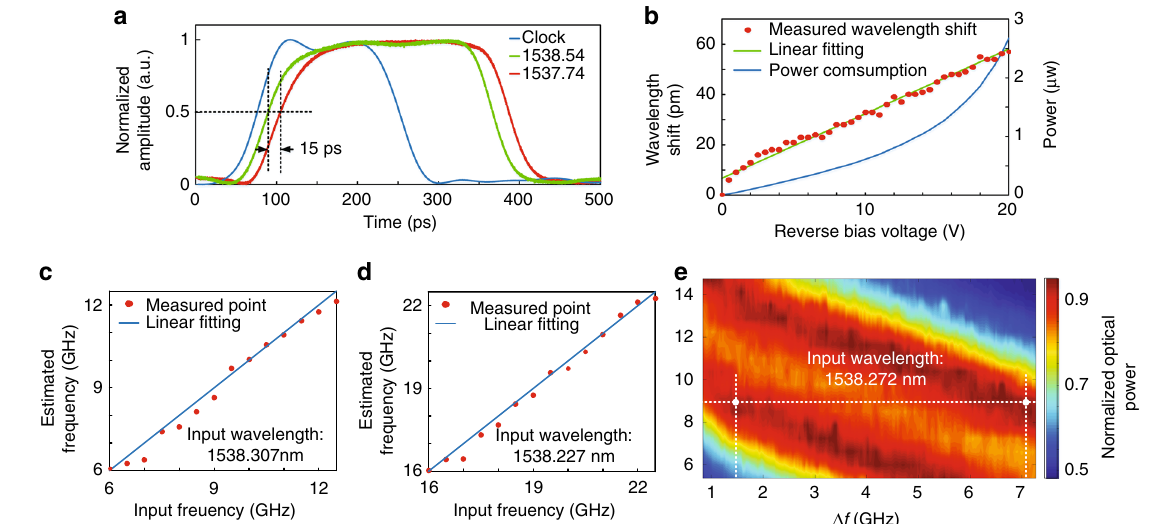
Fig. 6 Experimental results of microwave time delay and frequency identi fi cation. a Time-domain measurement when the fabricated grating is recon fi gured to be a chirped grating. b Peak wavelength shift and power consumption with the bias voltages. c Estimated frequencies when the wavelength of the optical carrier is 1538.307 nm. d Estimated frequencies when the wavelength of the optical carrier is 1538.227nm. e Two-frequency measurement test when the wavelength of the optical carrier is swept from 1538.227 to 1538.307